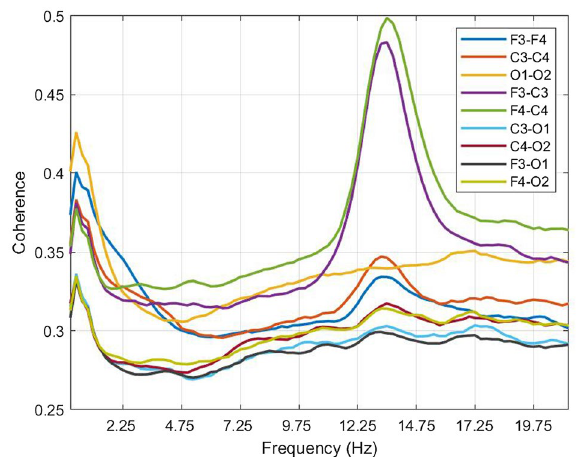
Figure 1. Non-rapid eye movement (NREM) sleep coherence spectra for a subset of connections averaged across 31 infants. The connections were chosen to ensure comparability to previously published work regarding sleep EEG coherence in children 13 and adolescents 14 and are illustrated in different